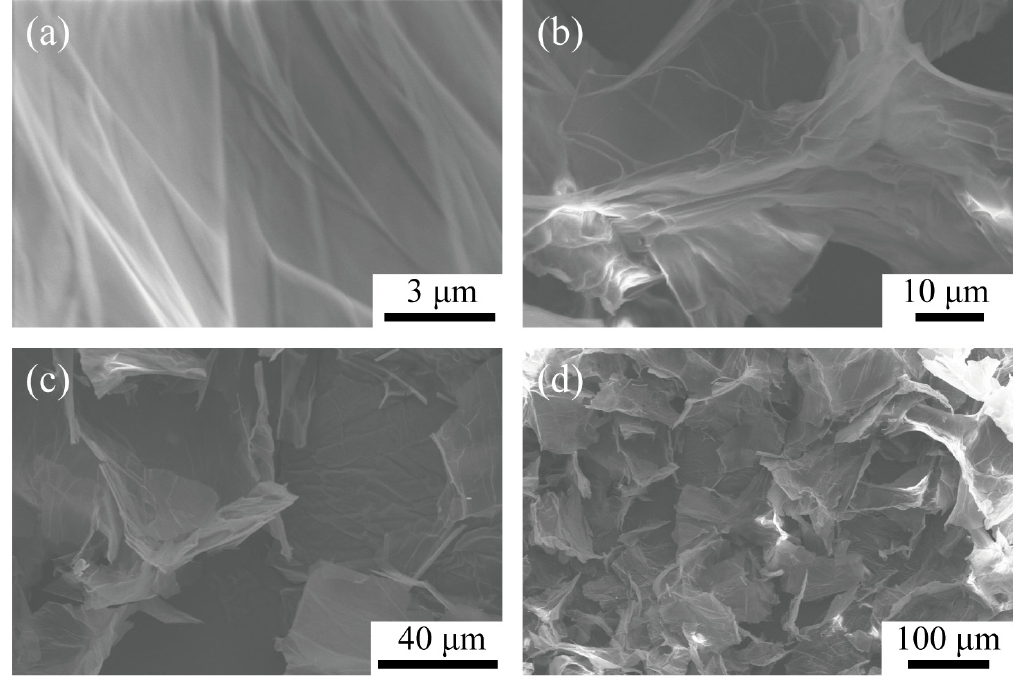
Figure 2. SEM images of CAG-GO20%. ( a ) Magnify 30000 times. ( b ) Magnify 7000 times. ( c ) Magnify 2500 times. ( d ) Magnify 680 times.